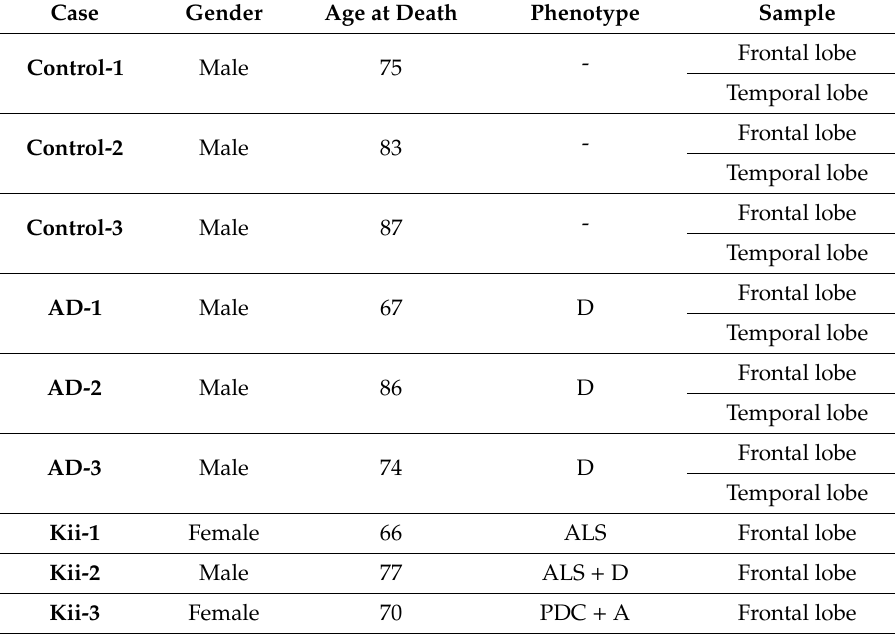
Table 1. Profiles of brain